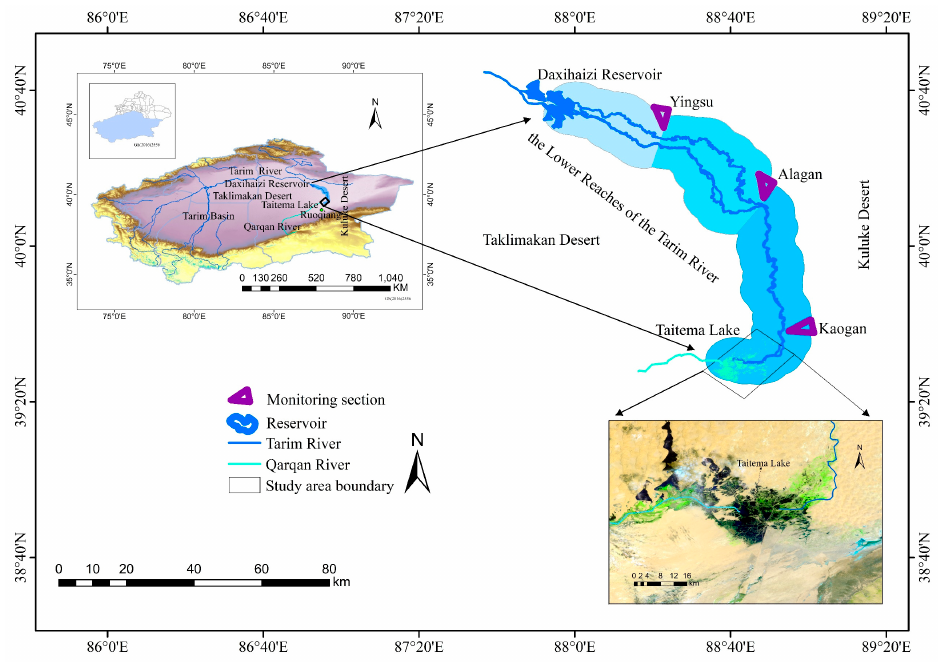
Figure 1. Geographical location of study area. The Taitema Lake region has an extreme continental climate, making it extremely arid. The Ruoqiang meteorological station records show that the average annual